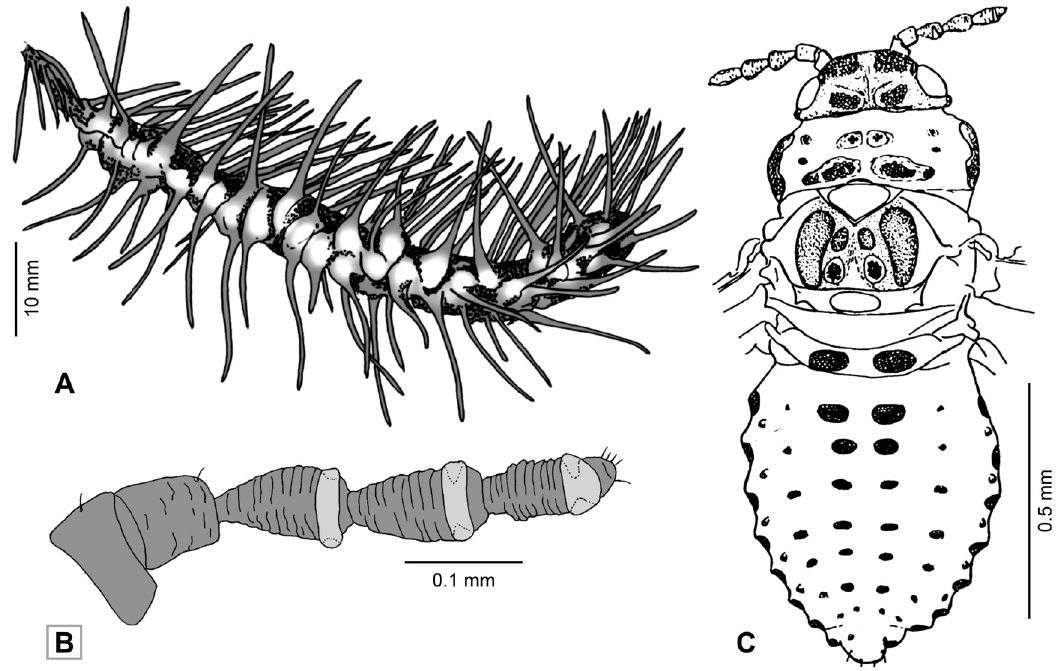
Fig. 16. Adelges (Gilletteella) cooleyi (Gillette, 1907). A . Gall on Picea (after Carter 1976). B . Antenna of gallicola (modified from Annand 1928). C . Sexupara (after Carter 1971, redrawn and modified from Heie